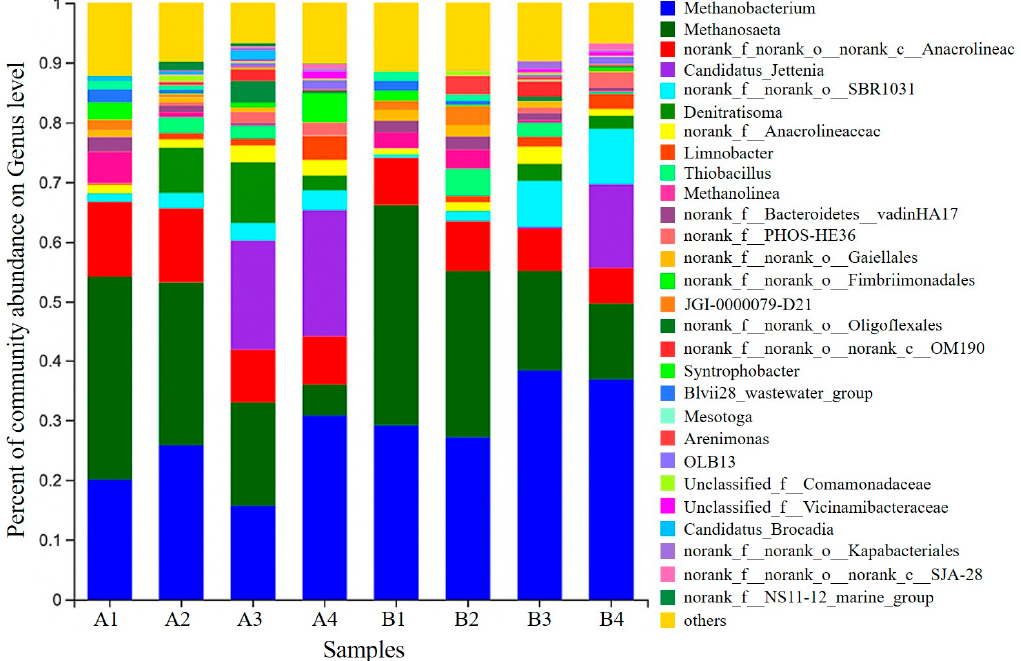
Figure 6. Microbial genus horizontal community structure distribution map; microbiological assays were performed on day 1, day 30, day 120, and day 160 for R1 and R2, with samples numbered A1, A2, A3, and A4 (R1); B1, B2, B3, and B4 (R2).